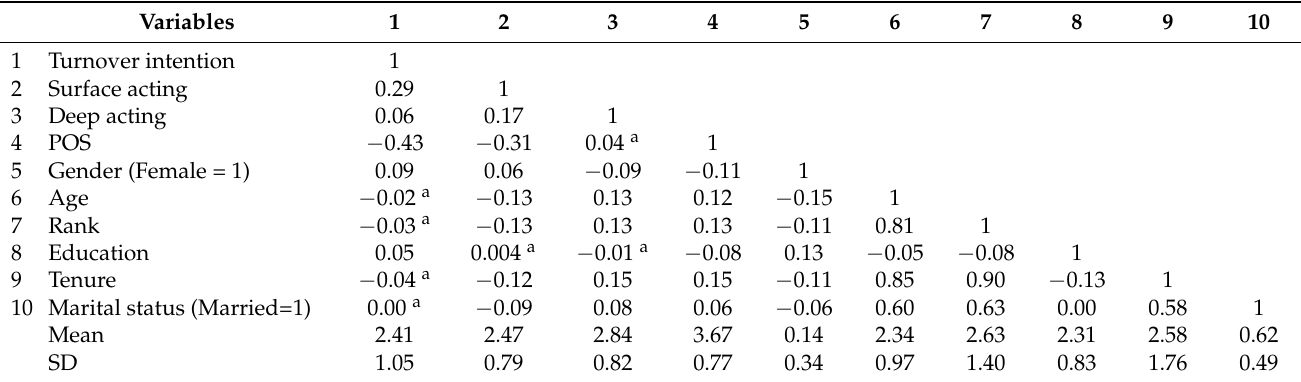
Table 2. Descriptive statistics and